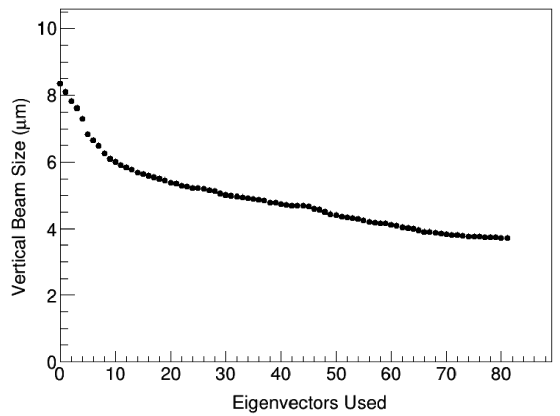
FIG. 4. The average simulated beam size over 1000 instances of a lattice with random misalignments after correcting dispersion and coupling using our Levenberg-Marquardt-based tuning and then minimizing the beam size using our first N eigenparameters. The average initial beam size is shown by the point lying on the vertical axis. Although not as stark as when starting from an uncorrected lattice, we still see that the first few eigenvectors contribute a disproportionate amount to the reduction in beam